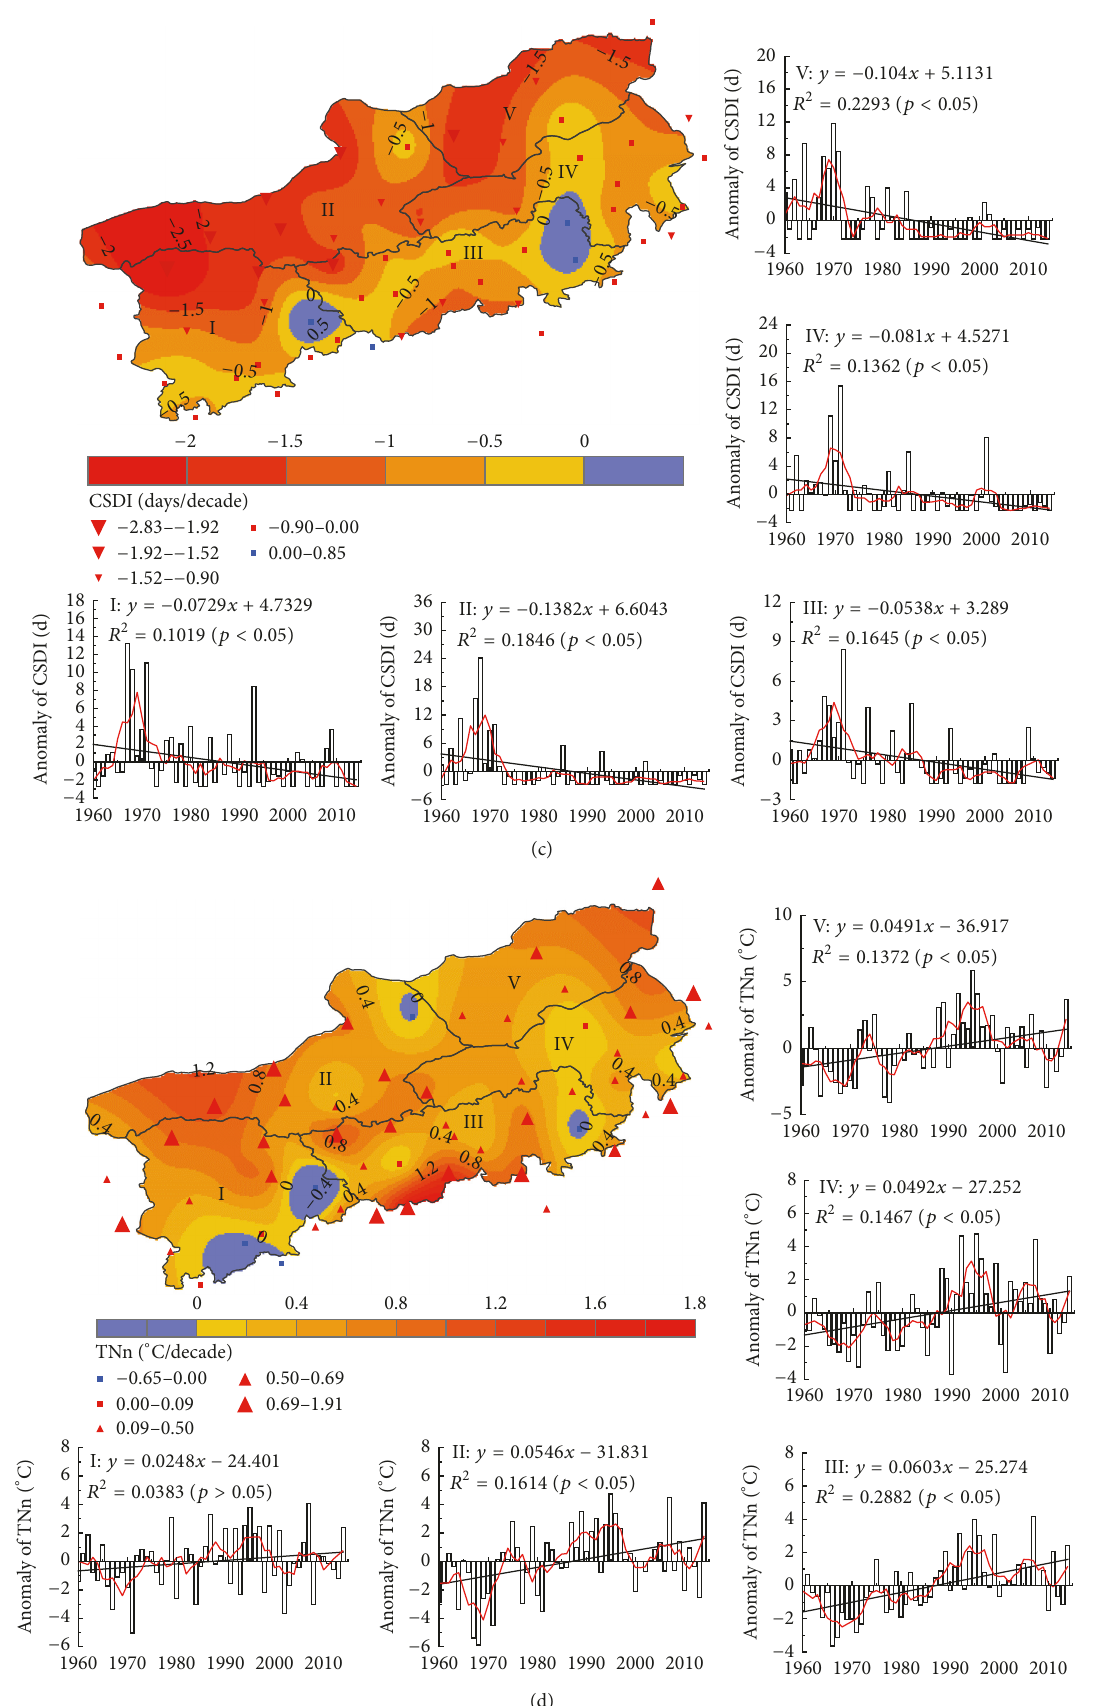
Figure 9: Spatial patterns of the trend slopes of cold-related indices across the BTSSR and anomaly of subregional indices curves, 1960–2014. The black line represents the linear trends for (a) TN10p, (b) TX10p, (c) CSDI, and (d) TNn. The redline represents the 5-year moving